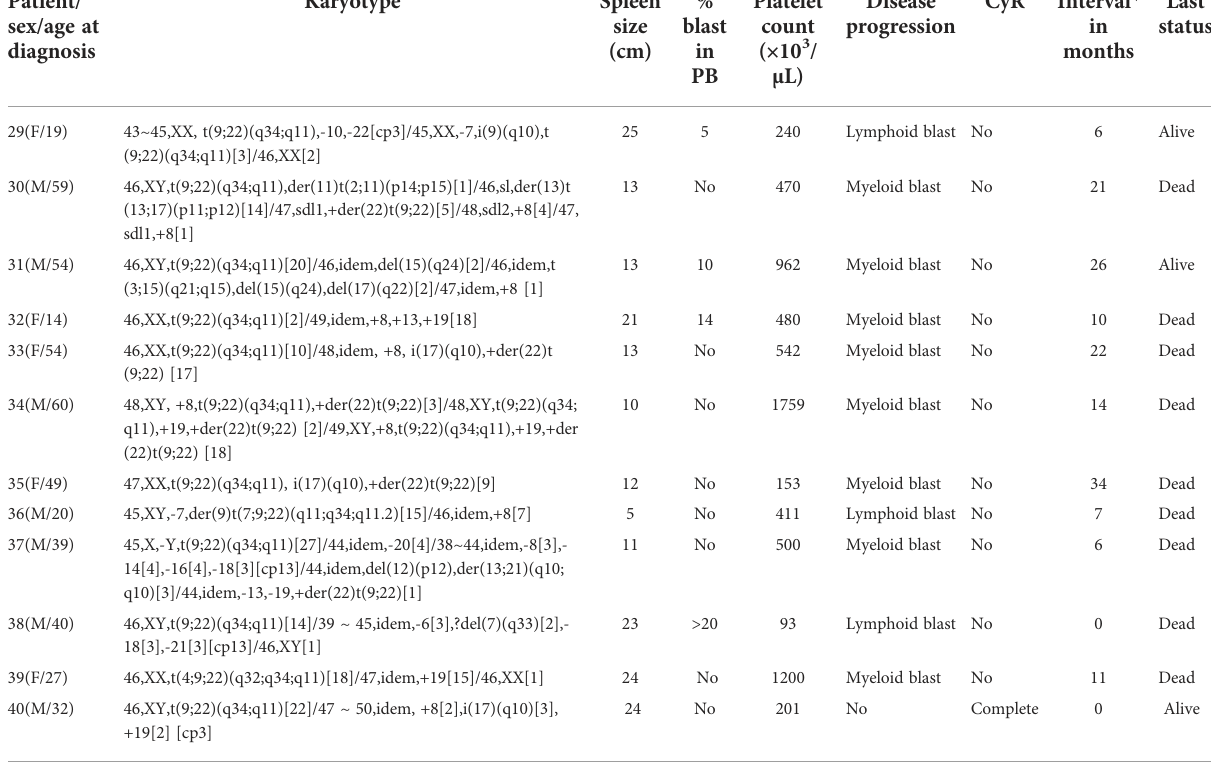
TABLE 1 (D): Group 4 (complex